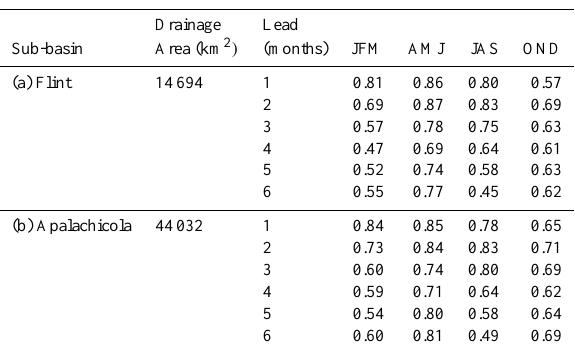
Table 3. Rank correlation between seasonal soil moisture forecasts and seasonal observed streamflow at (a) Flint River at Newton, GA; and (b) Apalachicola River at Chattahoochee, FL. Locations of these sites are shown in Fig. 1a. All correlations are statistically significant ( >